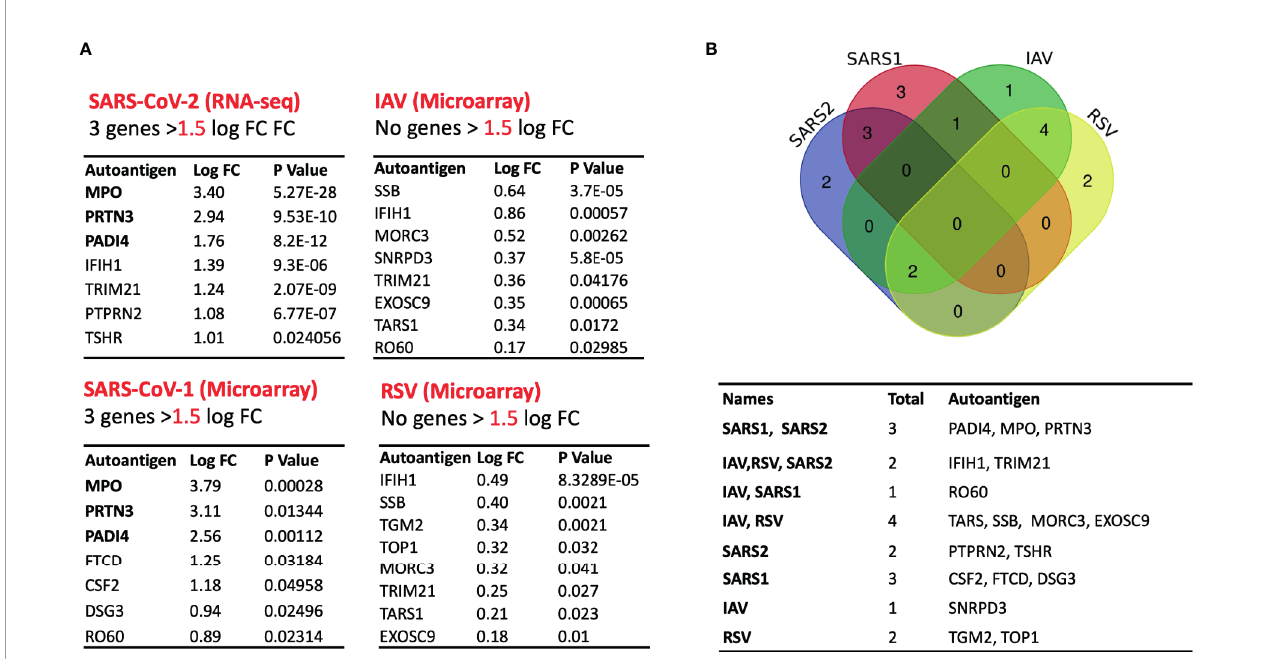
FIGURE 6 | Expression of autoantigens during COVID-19 and other viral infections. The following datasets were used to compare expression of autoantigens between SARS-CoV and other viral infections; GSE17156 (n = 17 IAV vs n = 17 controls), GSE17156 (n = 20 RSV vs n = 20 controls), GSE1739 (n = 10 SARS- CoV-1 vs n = 4 controls), and EGAS00001004503 (n = 39 COVID-19 vs n = 10 controls). (A) Log fold change in the expression of autoantigens following infection with SARS-CoV-1, SARS-CoV-2, IAV, and RSV relative to healthy controls. (B) Intersection of upregulated autoantigen signatures in four different respiratory viral infections, IAV, RSV, SARS-CoV-1, and SARS-CoV-2. Three top upregulated autoantigens (PADI4, MPO, and PRTN3) are shared between SARS-COV-1 and SARS- COV-2. For all analyses, p < 0.05 was considered signi fi cant. IAV, in fl uenza A virus; RSV, Respiratory syncytial